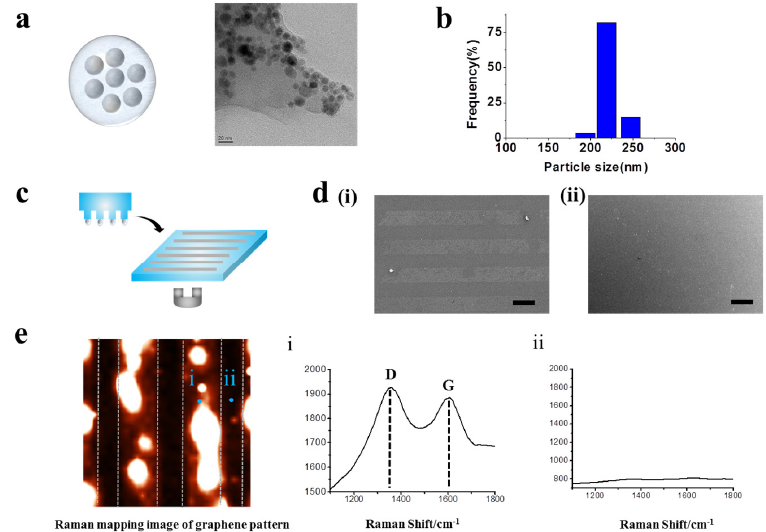
Figure 2. Pattering GO ‐ encapsulated nanoparticles. ( a ) Schematic diagram and TEM images of synthesized GOMNPs. ( b ) DLS data of synthesized GOMNPs. ( c ) Schematic diagram illustrating patterning with and without magnetic force. ( d ) SEM images of patterns generated on polydimethylsiloxane (PDMS) substrate. Patterned with magnetic force ( i ) and without magnetic force ( ii ) (Scale bar: 100 μ m). ( e ) Raman imaging of GO hybrid line pattern generated on PDMS. The X and Y axes were 100 μ m × 100 μ m. Raman spectra obtained from the spot ( i ) and ( ii ) from the Raman mapping image that proves the presence and absence of GO based on strong Raman peak.